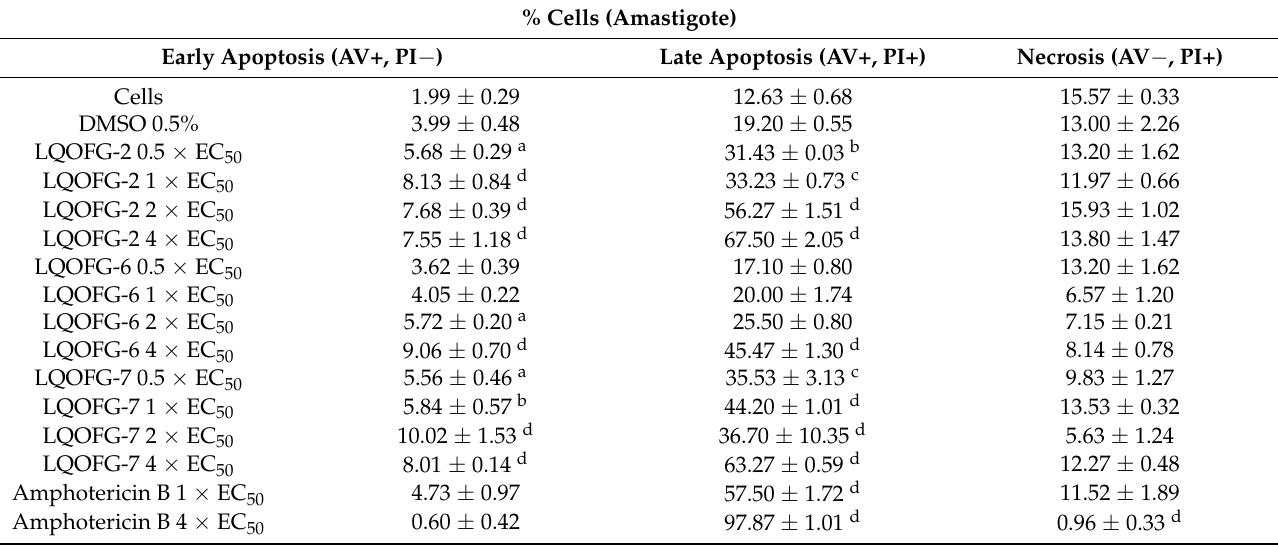
Table 3. Percentage of cell death by apoptosis/necrosis of L . infantum axenic amastigotes treated with LQOFG-2, LQOFG-6, LQOFG-7, or AmB for 24